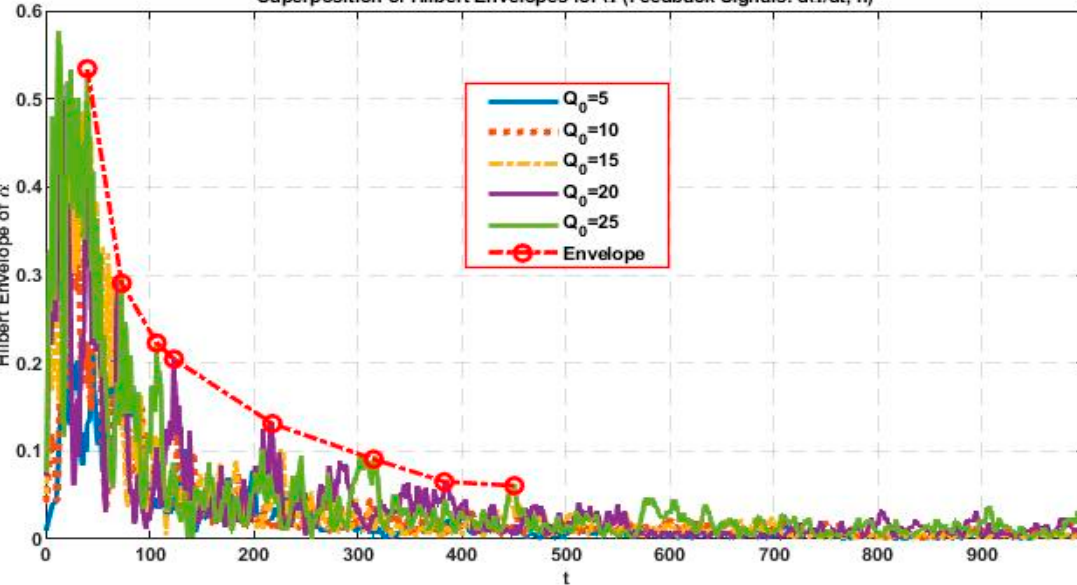
Figure 24. Instantaneous system damping. For Case II, we have seen that the linear combination of harmonic feedback signals involving the angular velocity and bending displacement can fully suppress the vibration of the wing. The prescribed perturbation signal simultaneously inhibits the multimodal energy absorption mechanism (caused by the cosine term) while providing the conditions for frequency entrainment in the lower frequency band (caused by the sinusoidal term). The frequency entrainment is caused by the closed- loop vibration mode closest to the fundamental tones identified in Figures 5 and 6. It has also been observed that the sinusoidal term has a strong effect on the first term of the perturbation signal and is the reason for the short-duration resonance captures. The effects of the control perturbation signal examined in Cases I and II are summarized in Figure 25. These short-duration resonance captures are